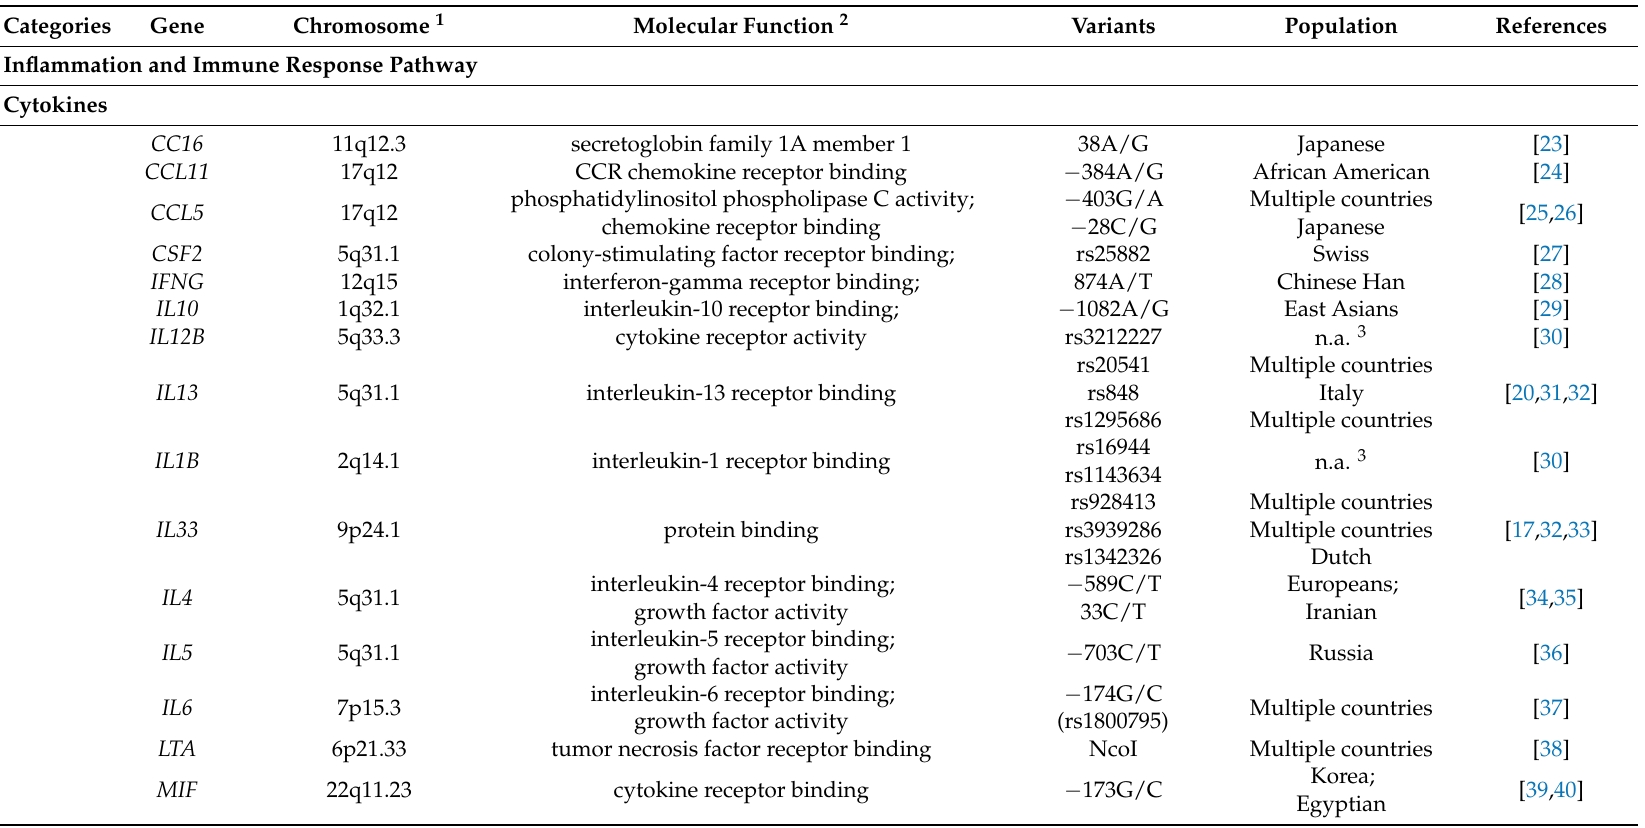
Table 1. Asthma-susceptible genes and